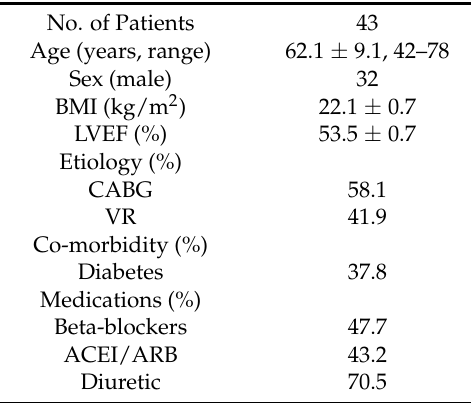
Figure 1. Patient flow during the present study. Table 1. Clinical characteristics of the patients.